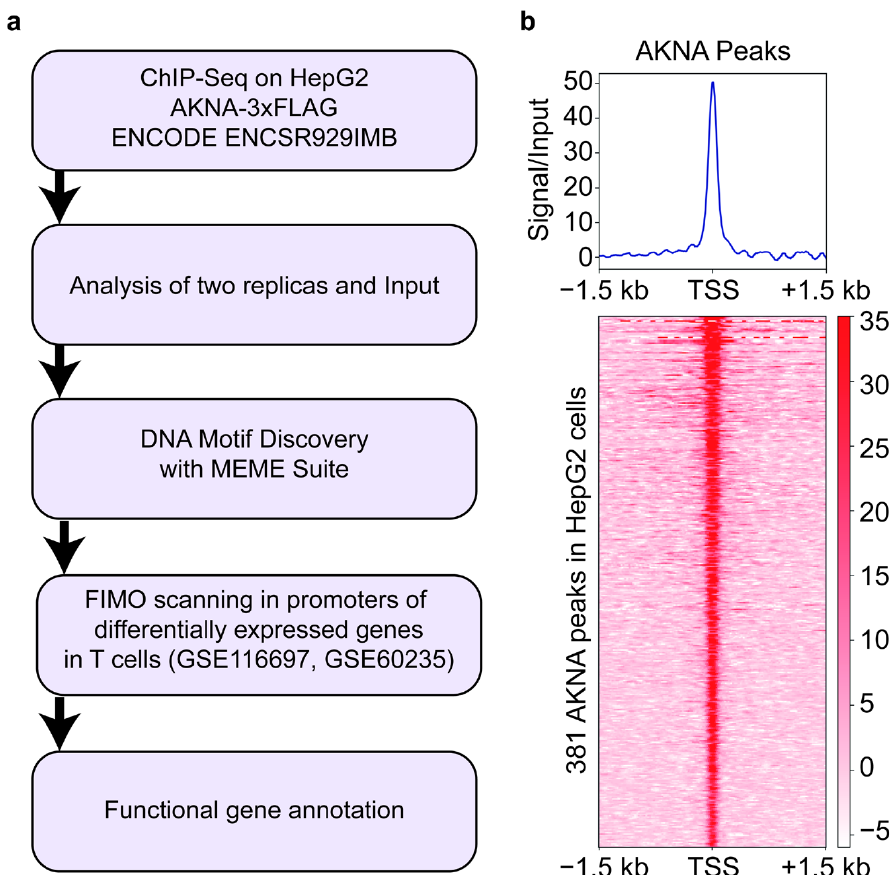
Figure 1. Genomic regions enriched with AT-rich motifs in “AKNA flag HepG2 cells”. ( a ) Flowchart of the methodology for the prediction of AKNA transcription factor binding motifs. ( b ) Heat map of the regions enriched with AT-rich motifs; the signal intensity in red shows the area with the highest enrichment of AT-rich motifs. To validate the presence of homogeneous enriched zones, the graph shows a single peak of AKNA. Peaks detected in the HepG2 cell line are statistically significant ( p < 0.05).